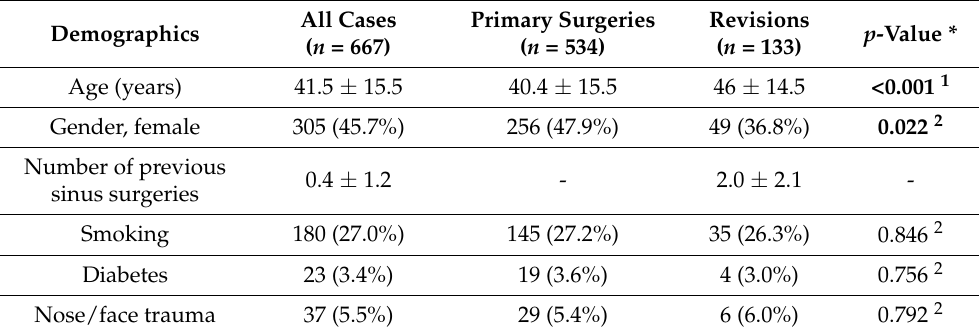
Table 1. Study participants’ demographical characteristics. Continuous variables are presented as mean ± SD (standard deviation), categorical variables as absolute number (percentage).